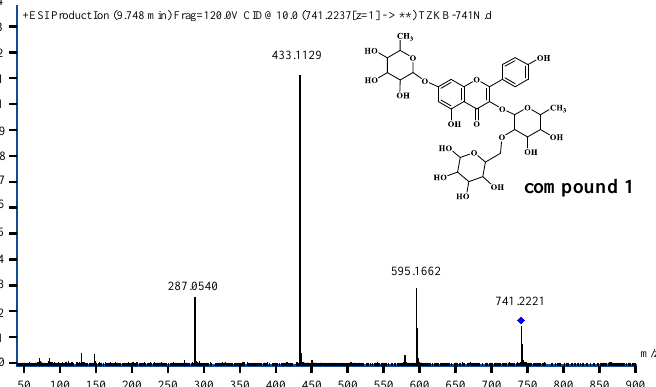
Figure 1. [M + H] + EICs of three flavonoids identified in the Arabidopsis thaliana (L.) not exposed to Tabun.